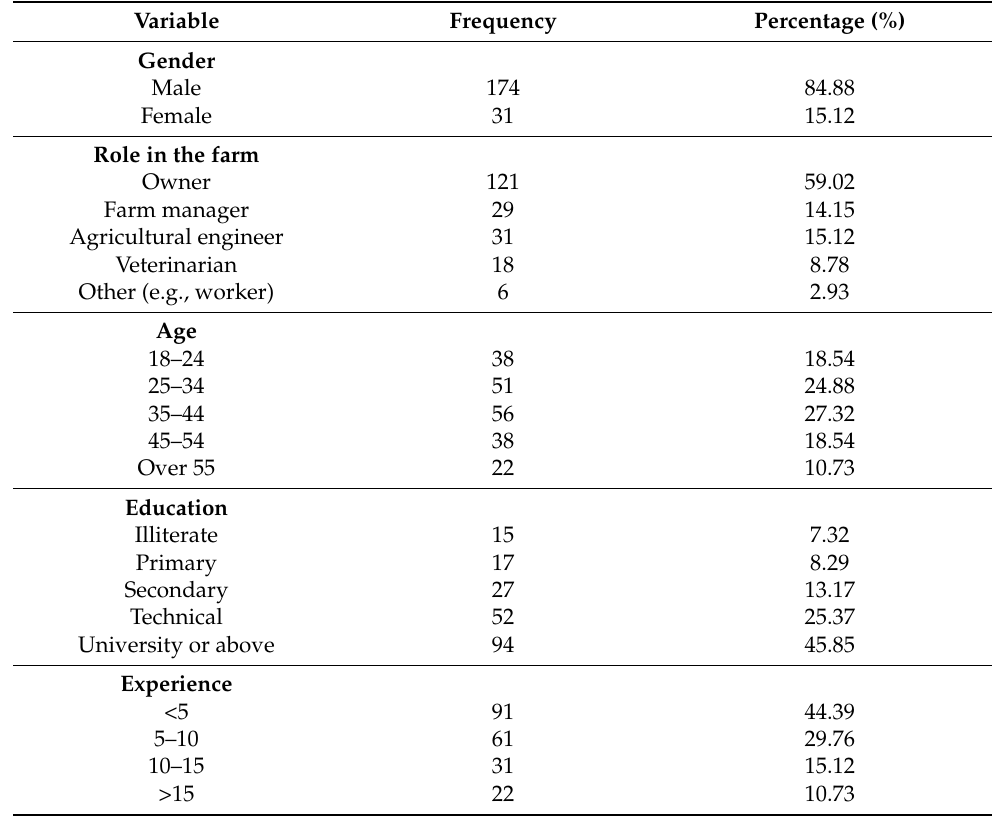
Table 1. Sociodemographic characteristics of respondents ( n =